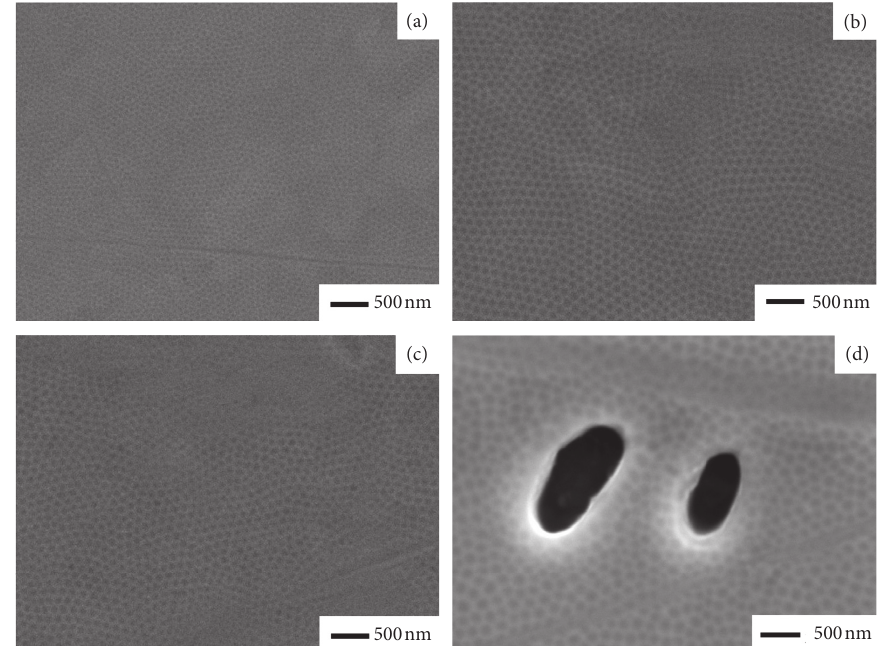
Figure 4: SEM images of stainless steel samples anodized under different anodizing times: (a) 300s, (b) 600s, (c) 1800s, and (d)